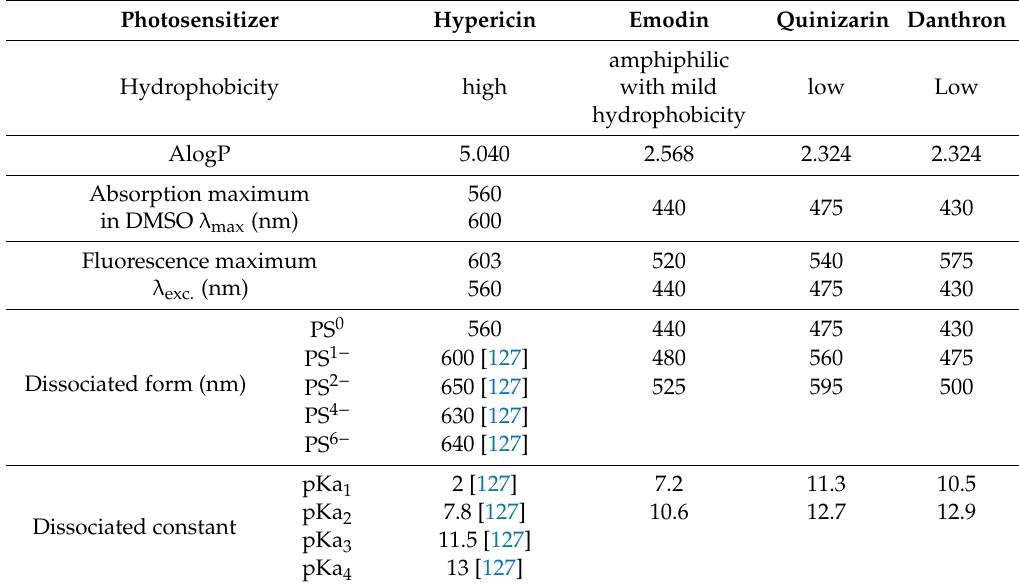
Table 1. Physical and chemical properties of selected photosensitizers (hypericin, emodin, quinizarin, and